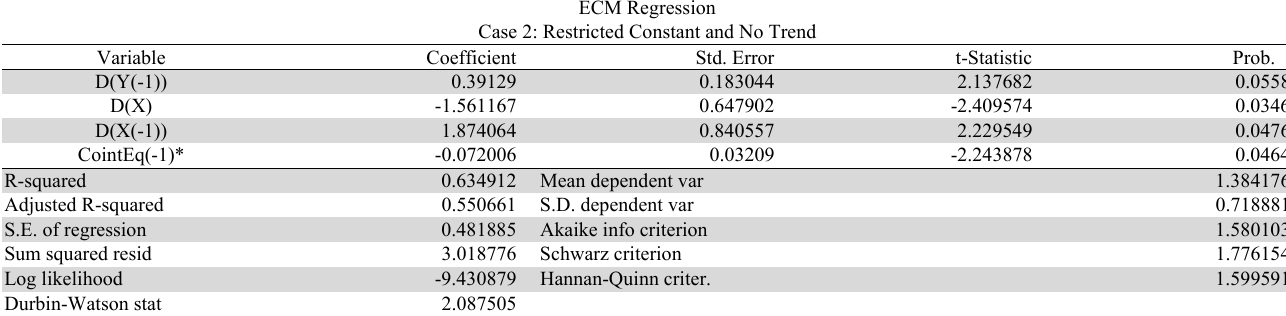
Results of error correction vector test